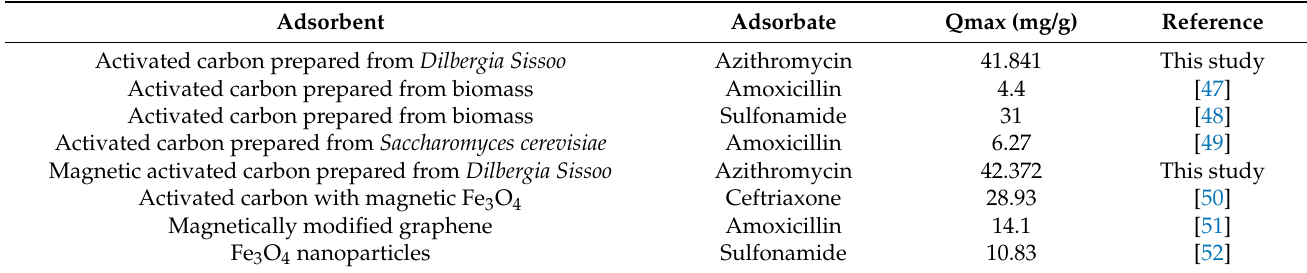
Table 5. Comparison of adsorption capacities of present adsorbents with those reported in literature.